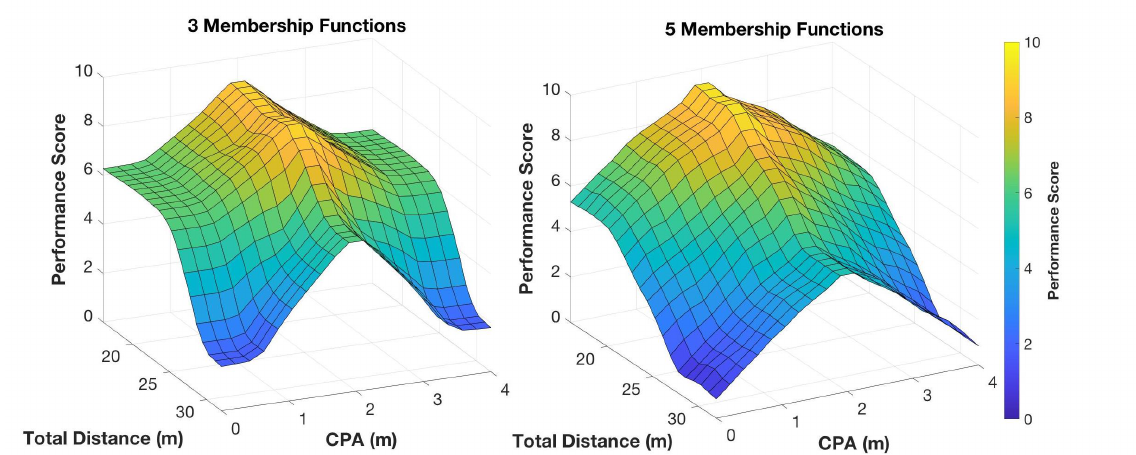
Figure 14. 3D plot MFs relating input variables (total distance and CPA) with corresponding output variables (performance scores).